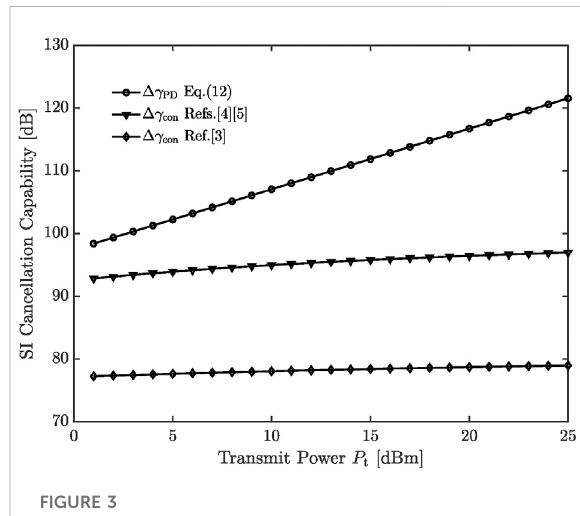
FIGURE 3 The SI cancellation capability comparisons between the pseudo-Doppler aided scheme and conventional